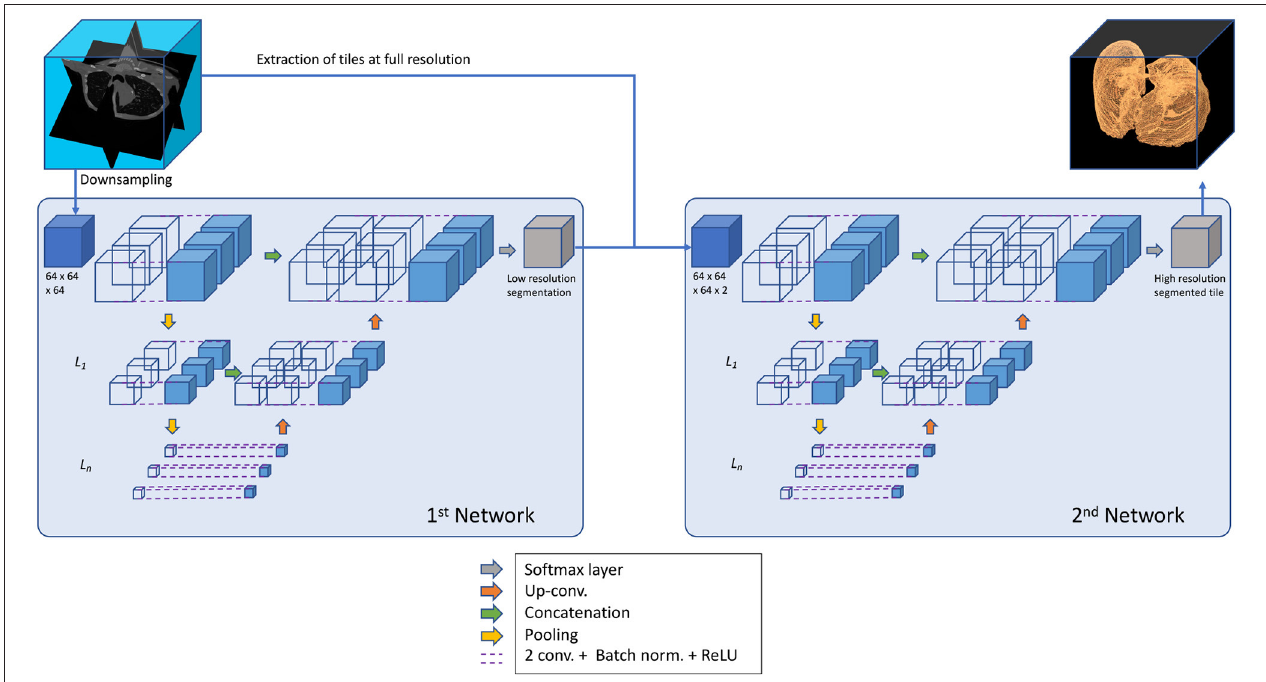
FIGURE 2 | General structure of the segmentation process applied in u 2 Net